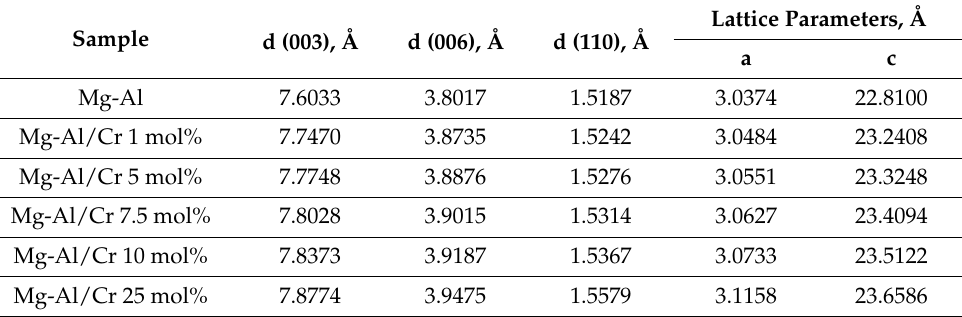
Table 1. The values of d-spacing and lattice parameters of Mg 3 Al 1 − x Cr x layered double hydroxides (LDHs) calculated by the Le Bail method.